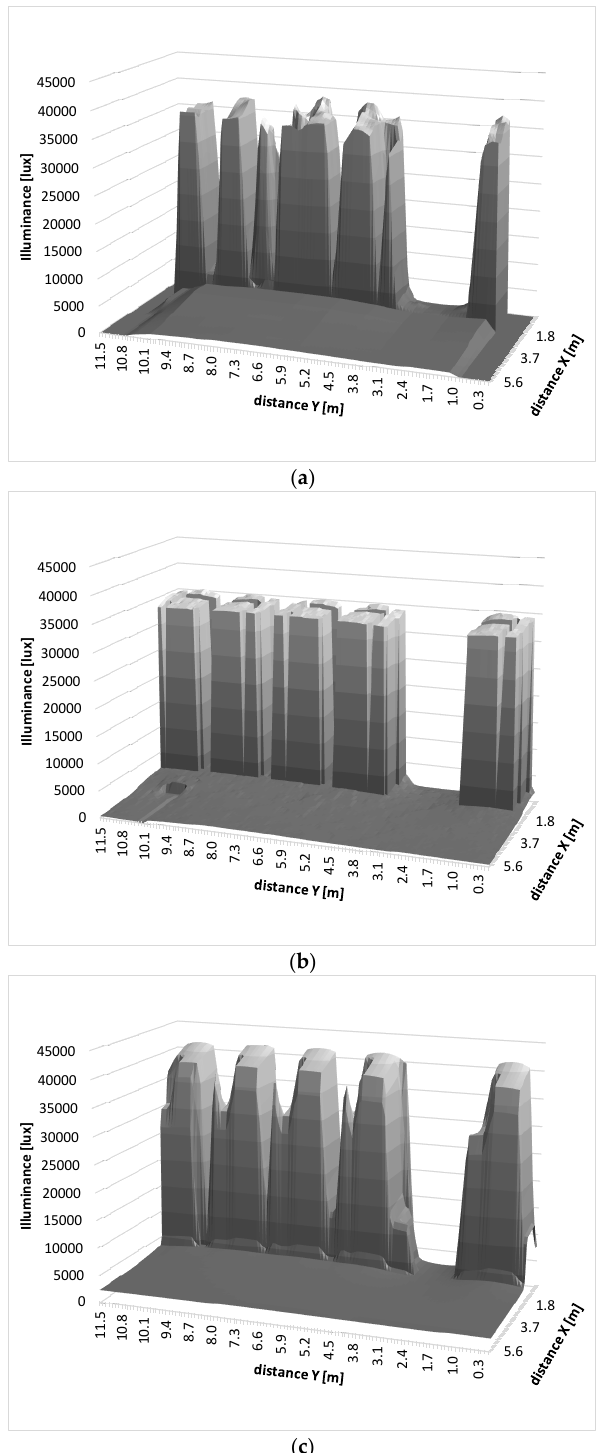
Figure 8. Illuminance distribution for sunny conditions (21 September 2018) ( a ) measured from 11:40–12:34, ( b ) DB (Radiance) 12:00, sunny clear day, ( c ) DB (EnergyPlus) 12:00, irradiation 610.64 W/m 2 .